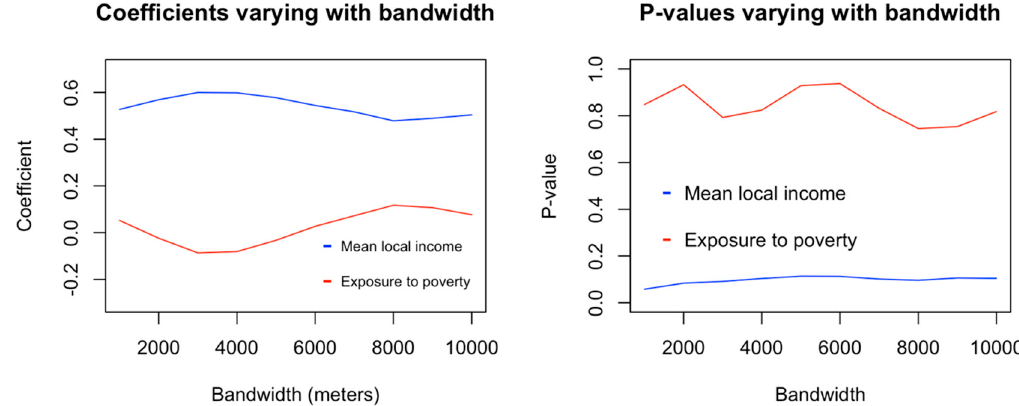
Figure 6. Coe ffi cient values and their significance varying with bandwidth for the case of burglary risk at